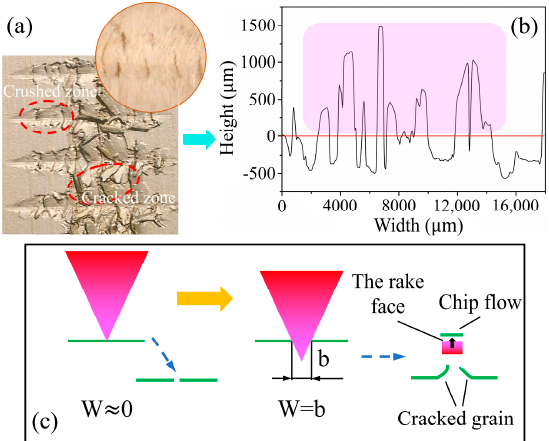
Figure 8. Analysis of plastic material deformation and chip formation when scratching Korean Pine ( λ = 90°): ( a ) 3D morphology of Korean Pine scratched surface; ( b ) cross-sectional profiles of scratched surface; ( c ) the interaction form between grit cutting-edges and wood grain.